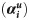
Generalizing the results.(a) Reward probabilities: In Exp 3, outcome contingencies for both stimuli were not static, but followed a random walk (restless 2-armed bandit task). All participants were exposed to the same contingencies. (b) Model recovery: model frequencies (blue shade) and exceedance probabilities (XP = 1) for each pair of simulated/fitted models, based on the AIC. (c) Model comparison: model frequencies and exceedance probabilities (XP) of the fitted models based on the AIC. Red lines: 0.25 chance level for model frequency and 0.95 threshold for exceedance probability. (d) Parameter analysis: learning rates of the winning model VS. Left: comparison between private (αp) and imitation (αi) learning rates. Right: comparison between imitation learning rates when observing the UD (αiu) and the SD (αis). ***p<0.001, Wilcoxon test. Underlying data can be found in https://github.com/hrl-team/mfree_imitation/. AIC, Akaike Information Criterion; DB, decision biasing; IQ, intelligence quotient; MB, model-based imitation; NS, not significant; RW, Rescorla–Wagner; SD, Skilled Demonstrator; UD, Unskilled Demonstrator; RW, Rescorla–Wagner; VS, value shaping.